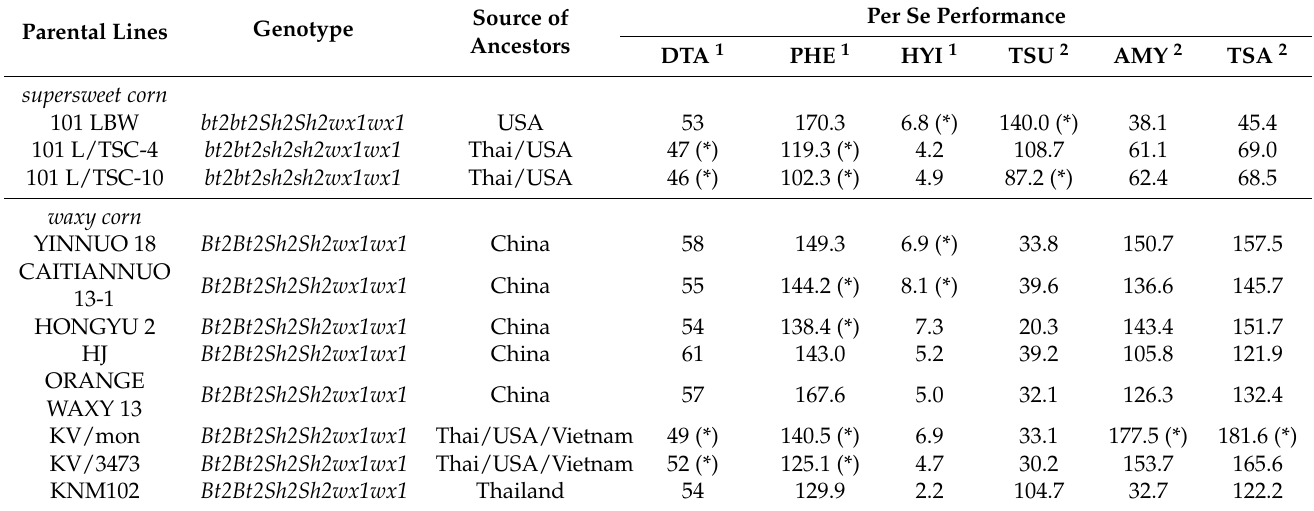
Table 1. Per se performance of 11 parental lines used in the